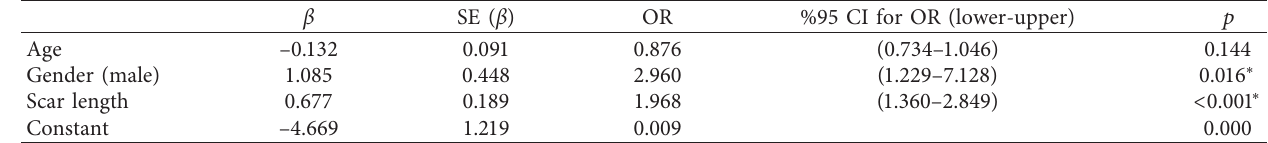
Table 3: Logistic regression analysis for chronic pain.